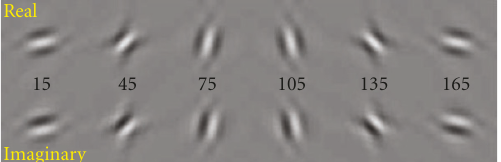
Figure 8: Impulse responses of original construction of Kingsbury’s modified complex dual-tree wavelets. Note that as direction is al- tered, the number of cycles per envelope remains approximately constant, which is directly associated with the property of approxi- mate rotation